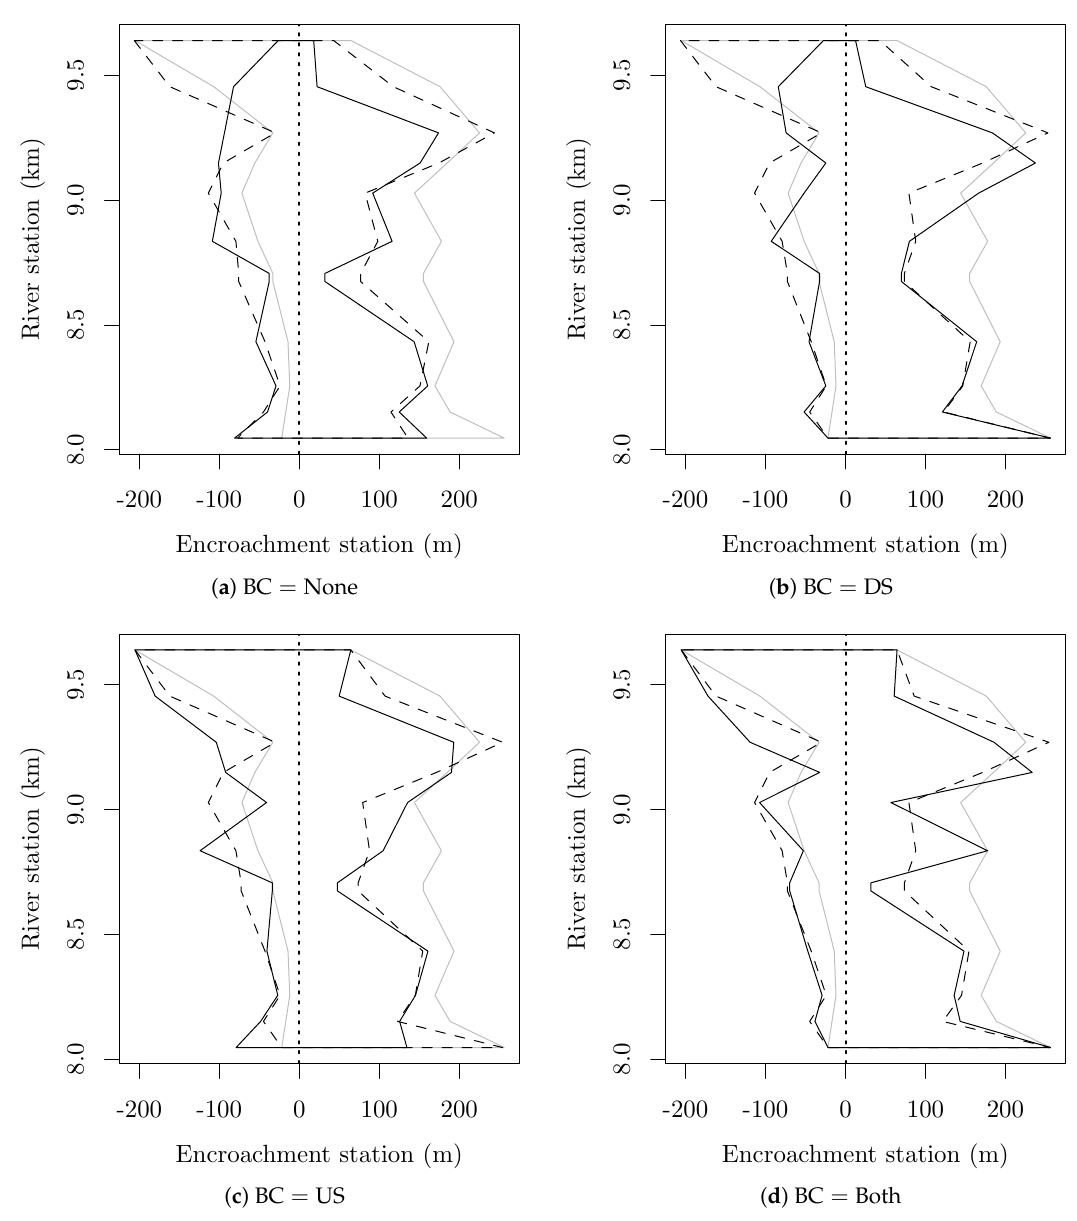
Figure 5. Graphical views of the left and right encroachment limits for the four different boundary conditions. Vertical lines at encroachment station 0 represents the river line. Negative and positive stations represent the left and right encroachment limits,